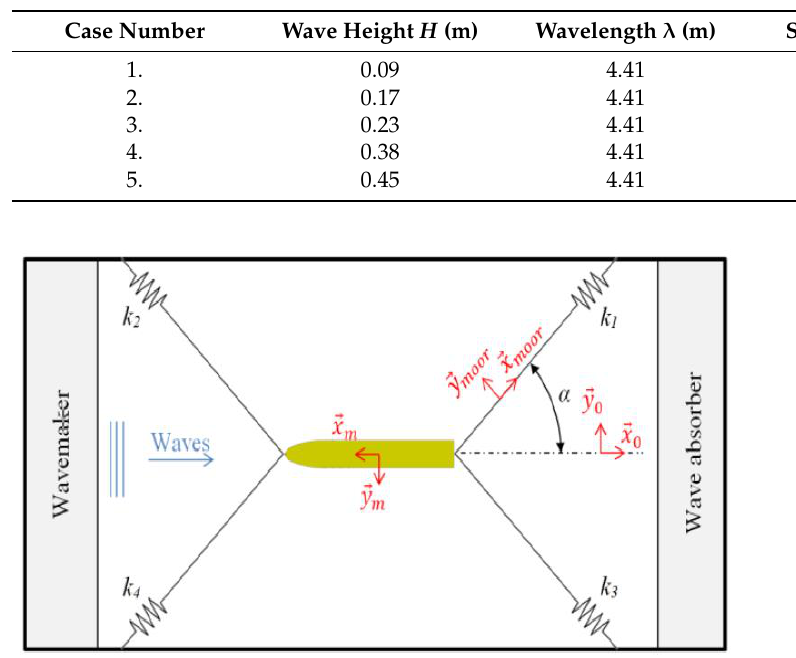
Figure 2. Top-view sketch of the mooring arrangement for a 6750 TEU containership.